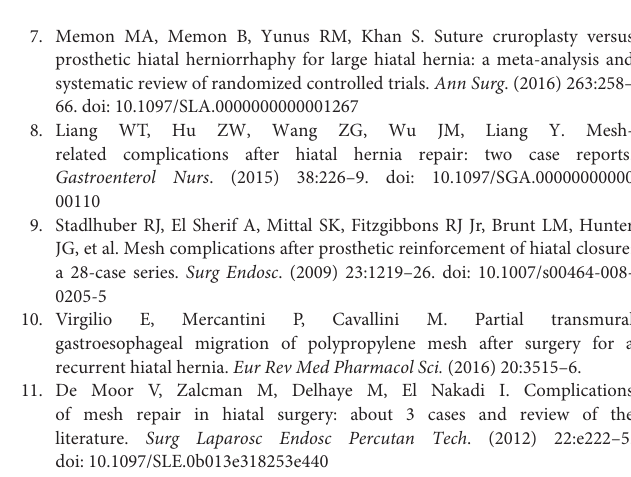
Supplementary Figure 1 | Image of mesh. The iron particles cause the dark strands visible in the close-up. Supplementary Figure 2 | Determining the HSA according to Granderath ( 14): the length of the crural commissure (R) is plotted on the x-axis; the length of the diaphragmatic commissure (B; measured following the curve of the commissure; see also Figure 1 ) is plotted on the y-axis. The blue line depicts the values of B as a function of R for which HAS = 5 cm 2 calculated as B ∗ R/2. Data points above the blue line indicate an HSA > 5 cm 2 and thus an indication for mesh reinforcement. Supplementary Figure 3 | Pre-operative symptoms of the patients that received a mesh implant (black bars; n = 18), and of patients that did not receive a mesh (gray bars; n = 15); multiple responses possible. Supplementary Figure 4 | Hernia type distribution according to Kahrilas ( 3). (a) Patients without mesh implant. (b) Patients with mesh implant. Supplementary Video 1 | 3D reconstruction of patient specific mesh (Patient a). Supplementary Video 2 | 3D reconstruction of patient specific mesh (Patient